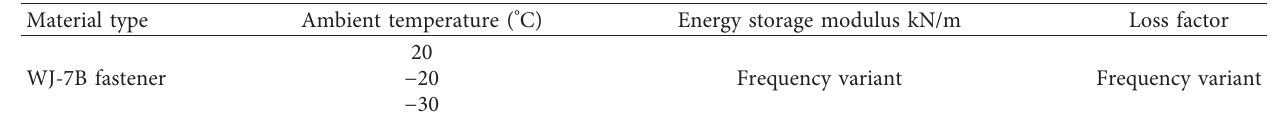
Table 4: Temperature/frequency characteristic calculation conditions.